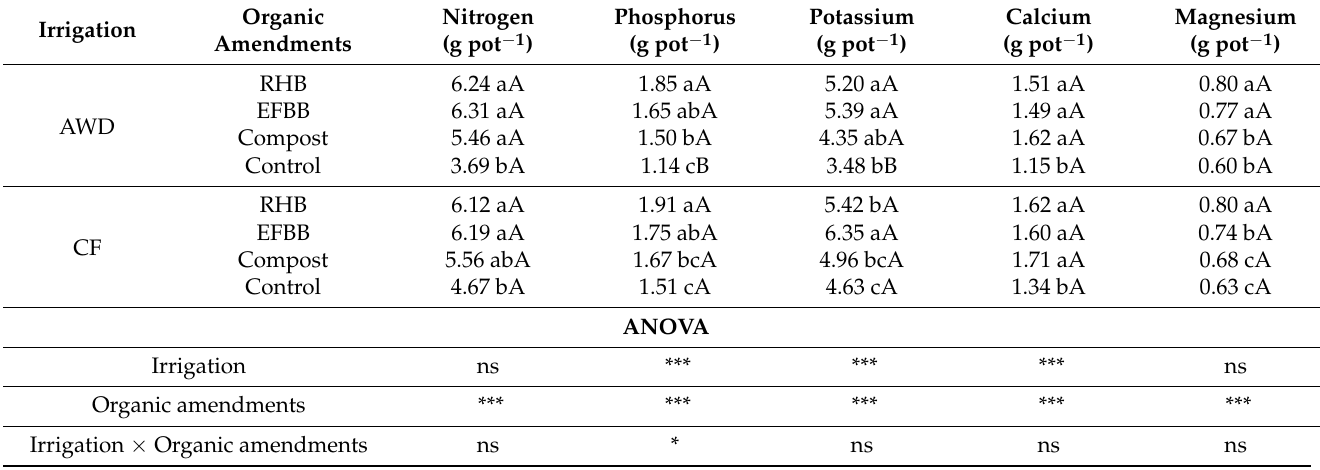
Table 4. Effect of organic amendments and irrigation management on nutrient uptake by